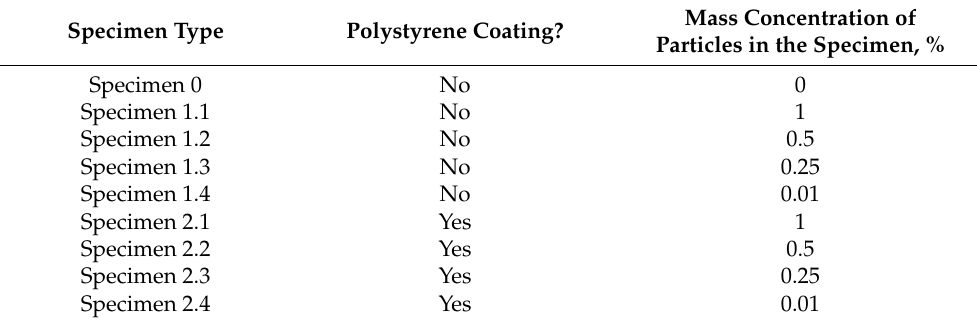
Table 1. Classification of the specimens.